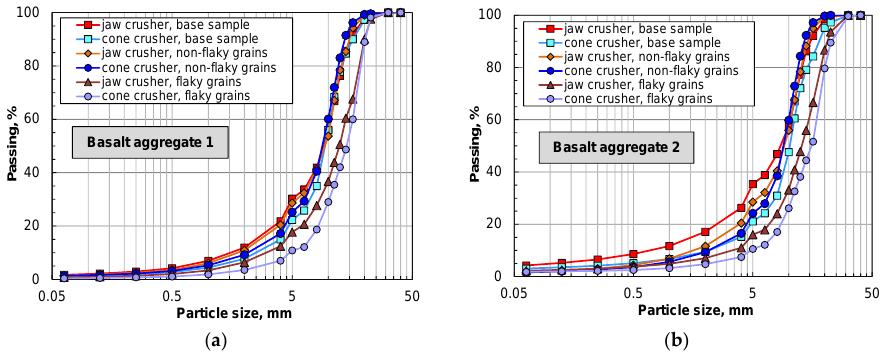
Figure 5. Particle size distribution of aggregates after crushing: ( a ) basalt 1; ( b ) basalt 2. After analyzing the grain size distribution and determining the shape and flakiness indexes, the basalt aggregate samples were crushed in the jaw crusher and the cone